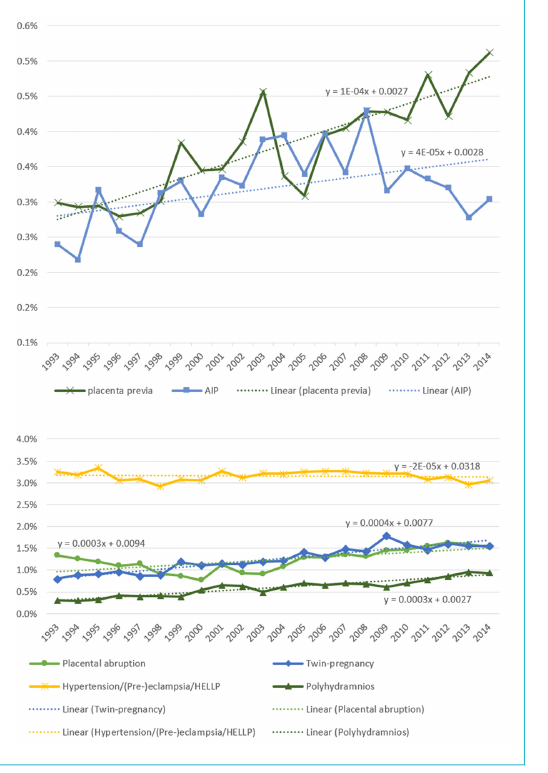
Figure 2: Incidence of significant pregnancy-related risk fac- tors for PPH over a 22-year period. Graphs show temporal trends of significant pregnancy-related risk factors for postpartum haemorrhage (PPH) based on logistic regression analysis. There was an increase in incidence of abnormally invasive placenta (AIP) ( above , blue line) and placenta praevia ( above , green line), the two risk factors with the highest odds-ratios. Y-axis indicates the incidence (in %) and x-axis shows the corresponding year.